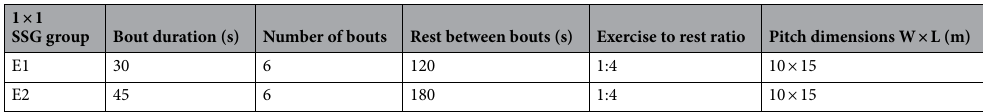
Table 1. Characteristics of small-sided games used during the study. SSG—small-sided game, W × L—width and length, E1—6 × 30 s 1 × 1 SSG, E2—6 × 45 s 1 × 1